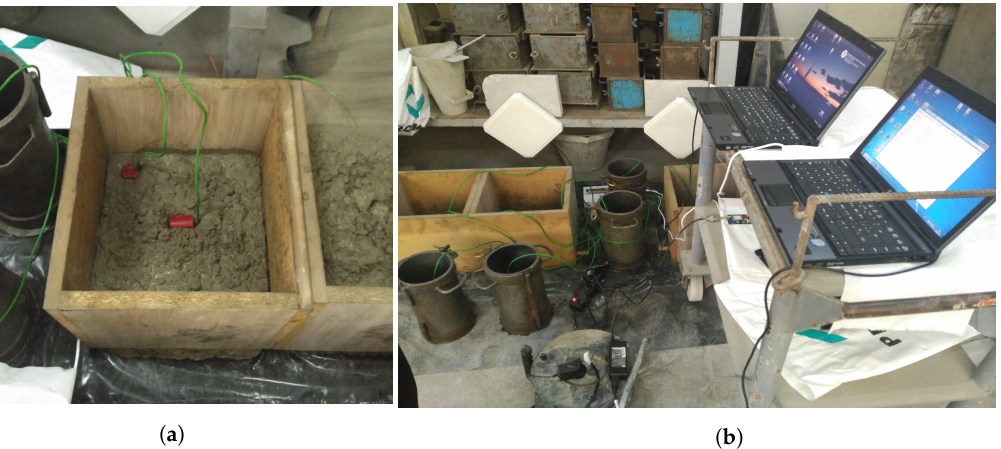
Figure 8. In-field measurement at PROMSA: ( a ) Location of the embedded RFID sensors and ( b ) layout of the whole measurement